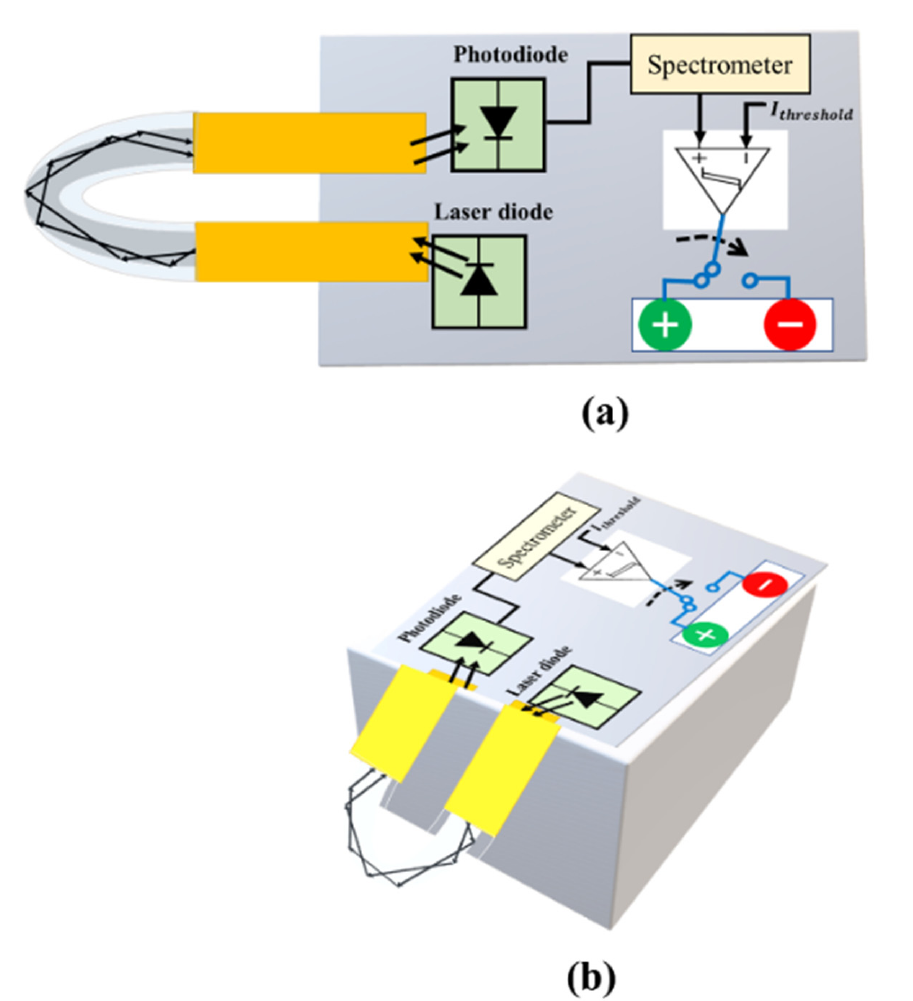
Figure 12. The proposed prototype will have a following shape. The U-shaped optical fiber probe connected to the laser and photodiode while green light shows a COVID positive, and COVID negative is reported by red light. ( a ) Shows front view while ( b ) shows lateral view of the prototype.